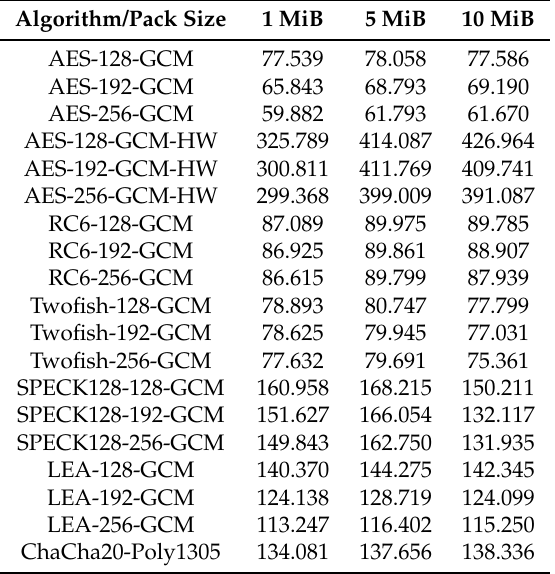
Table 4. Average encryption throughput (MiB/s) in the ARMv8-a Xiaomi device.